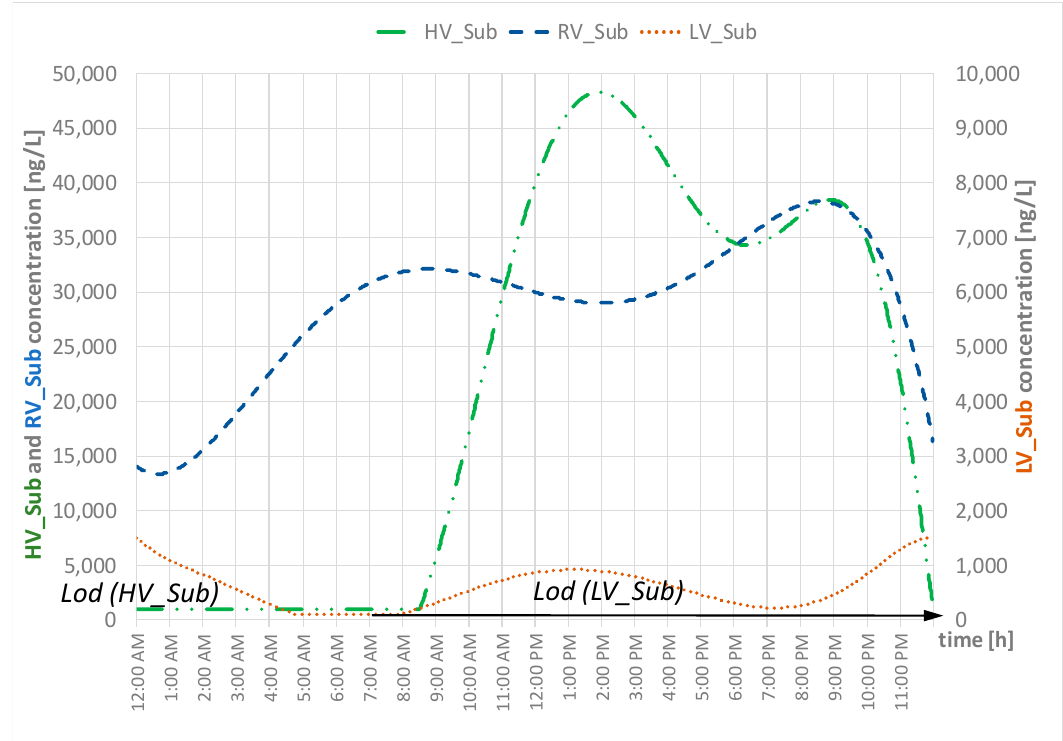
Figure 1. Concentrations versus time for the three key compounds considered in the study. Note that the Y-axis for the low variability substance (LV_Sub) is on the right and the Y-axis for the high variability substance (HV_Sub) and the random variability substance (RV_Sub) is on the left.